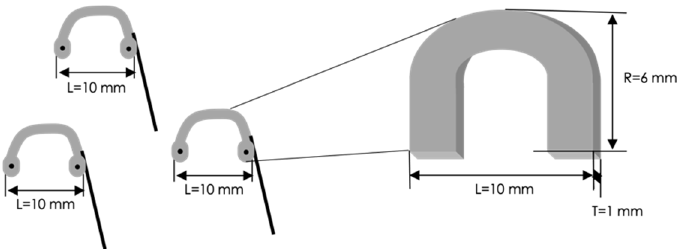
Figure 6. Geometric dimensions of the three electrodes embedded in the Prototype 3.